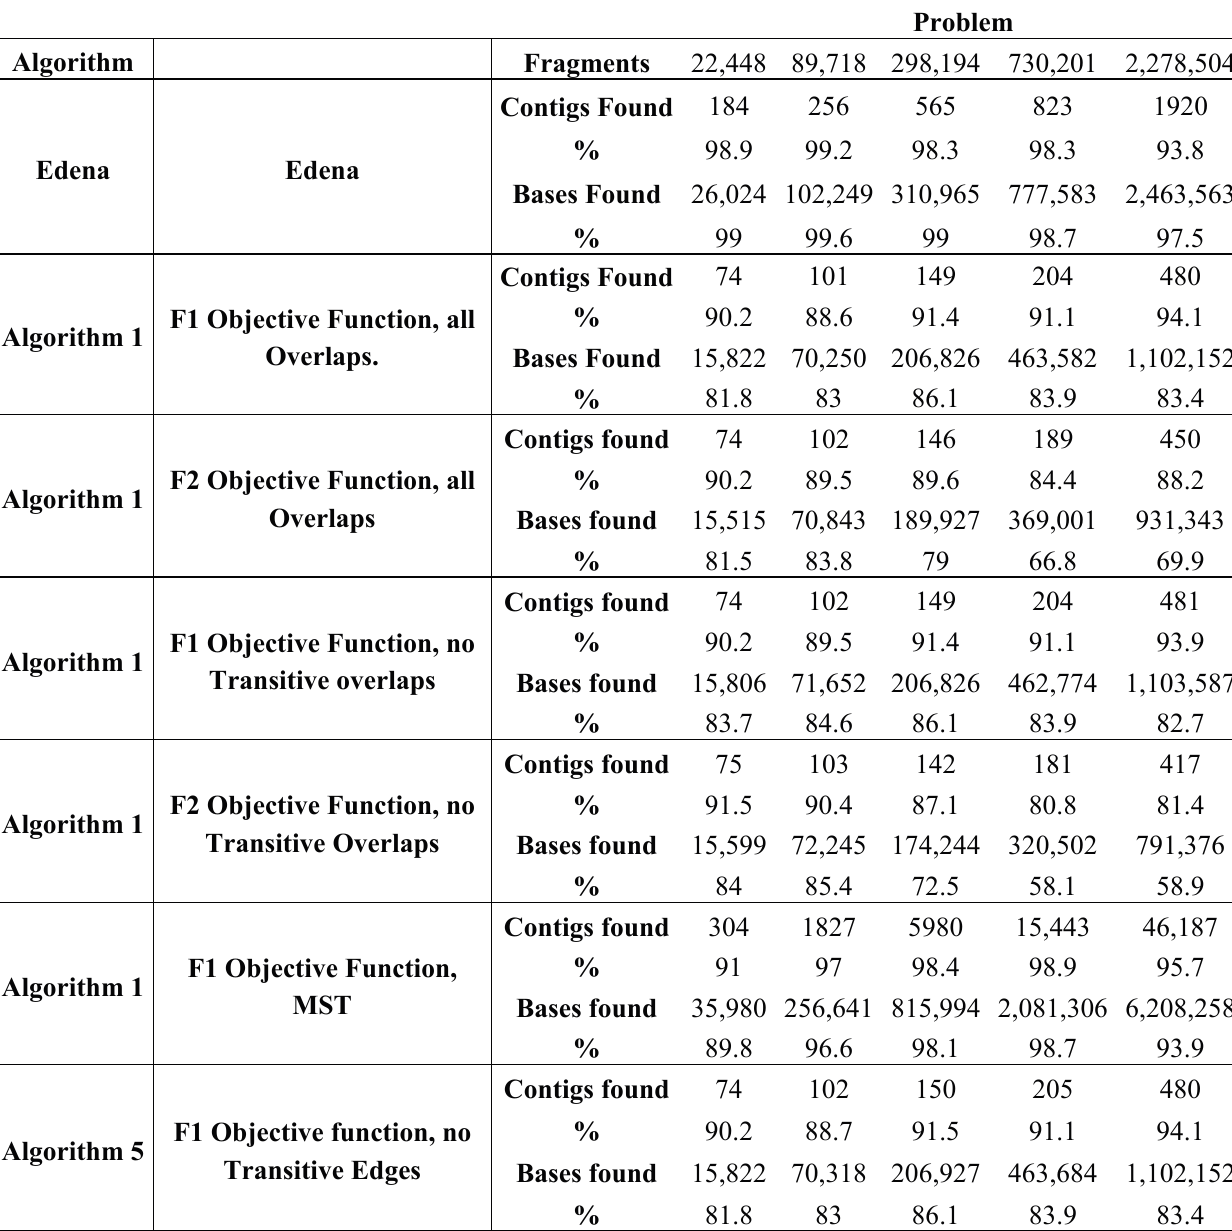
Table 5. Experiments